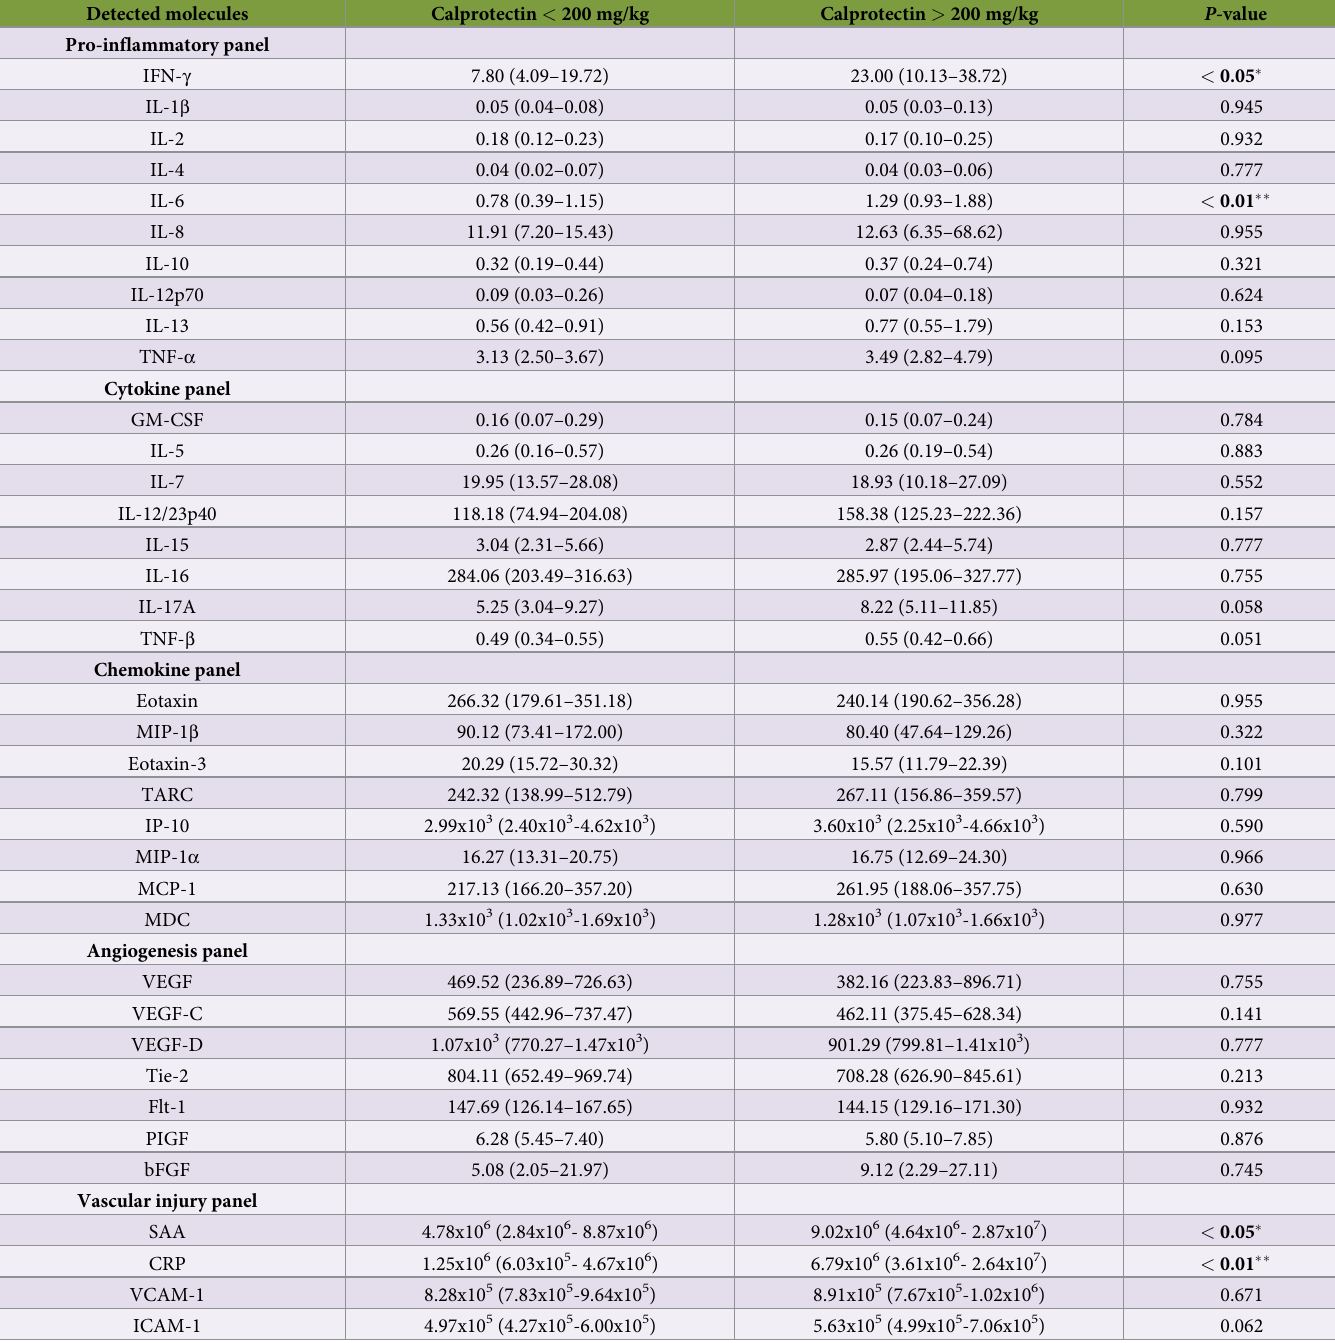
Table 2. Median (IQR) of serum levels of all detected molecules (pg/mL) in Crohn’s disease patients with ‘normal’ ( < 200 mg/kg) and increased ( > 200 mg/kg) fecal calprotectin